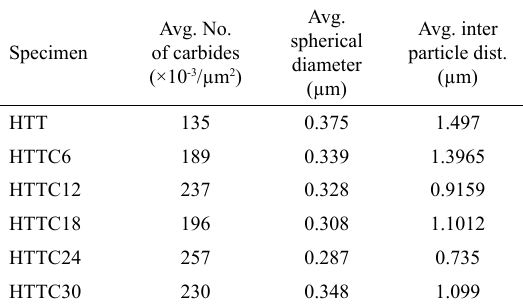
Table 3. Summary of population density of carbides.